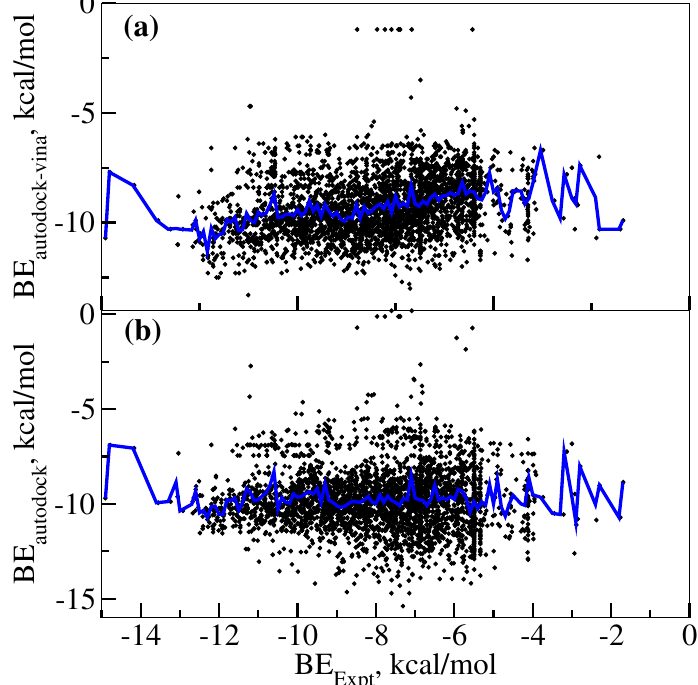
Figure 3. ( a ) Comparing the experimental and autodock-vina-based predicted binding free energies for various MAO-B ligand complexes. ( b ) Comparing the experimental and autodock4.0-based predicted binding free energies.The black spots represent different data points of the scatter diagram of experimental and predicted binding free energies. The plot in blue color shows F(BE expt ) as a function of experimental binding free energies. For an excellent prediction, this plot should be the same as the expression, y =